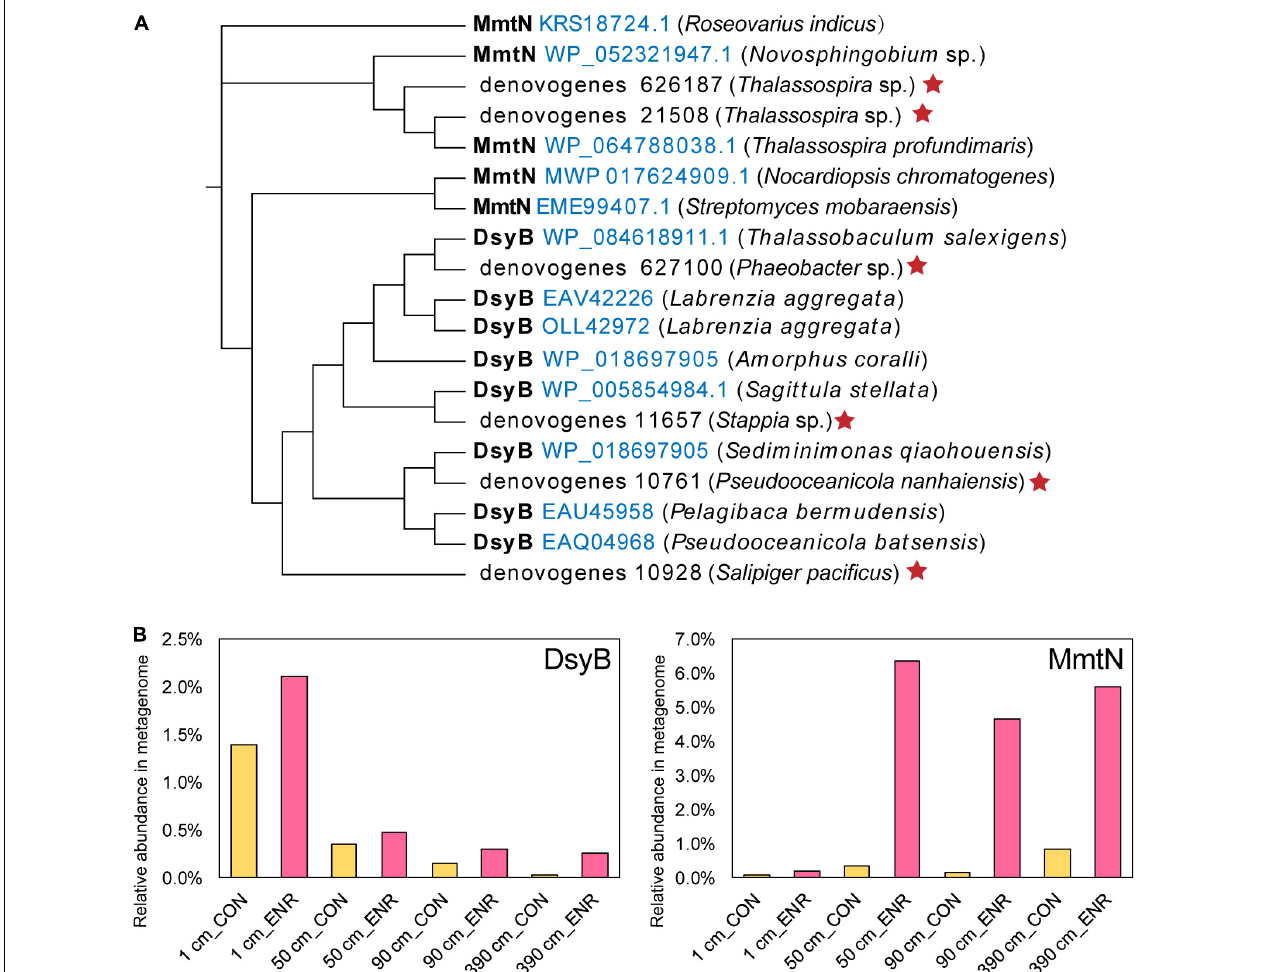
FIGURE 7 | DMSP synthesis proteins predicted from metagenomic analysis of enriched cultures. (A) Maximum-likelihood phylogenetic tree of DsyB and MmtN sequences from metagenomes (indicated by red stars) and functionally ratified proteins (with the Accession Number in blue). (B) The relative abundance of DMSP biosynthesis protein sequences in metagenomes. CON, the control group in normal MBM; ENR, the DMSP-enriched groups in modified